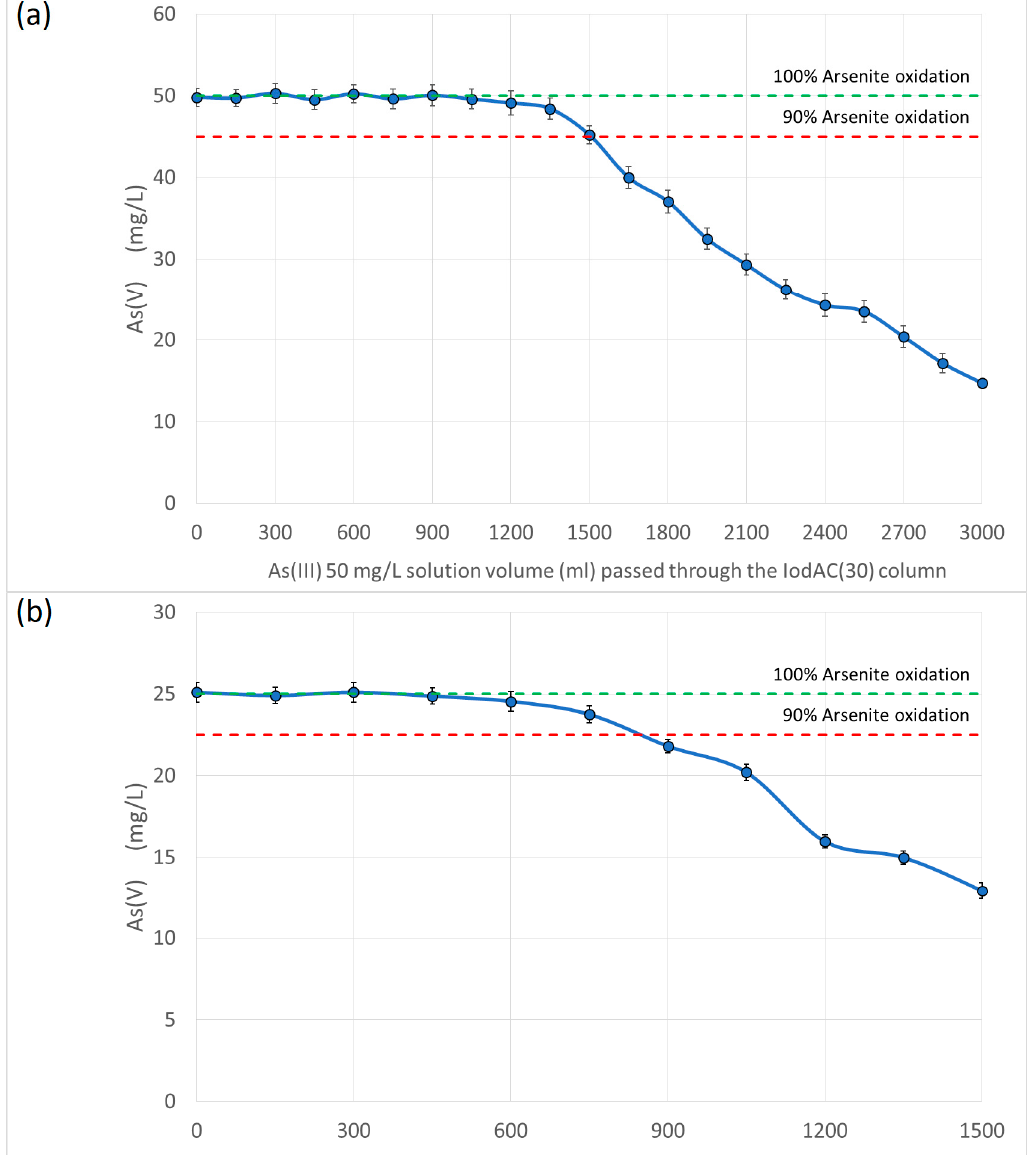
Figure 4. As(III) oxidation rate performance in column study: (a) Arsenate concentration in the output water using 3 cc of IodAC(30); (b) arsenate concentration in the output water using 3 cc of IodAC(10).